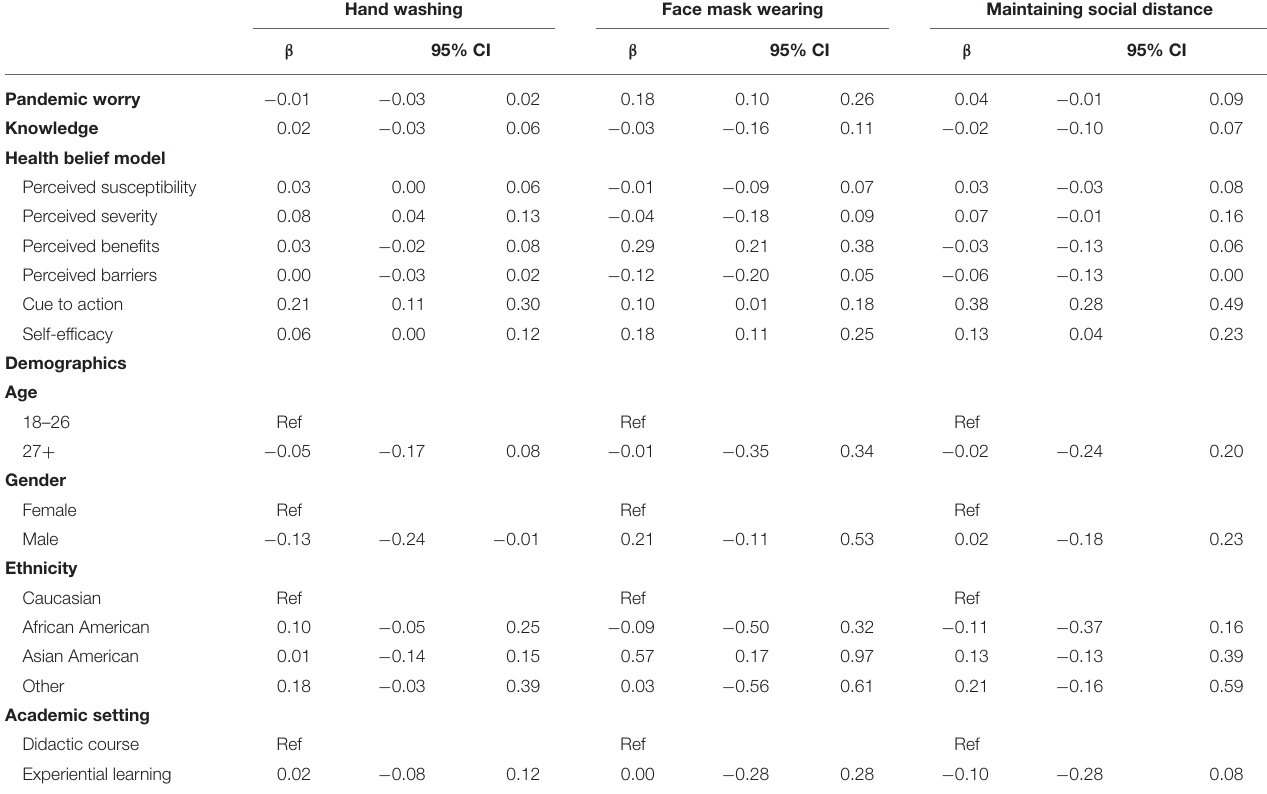
TABLE 3 | Factors associated with preventive health behaviors. Hand washing Face mask wearing Maintaining social distance β 95% CI β 95% CI 95%